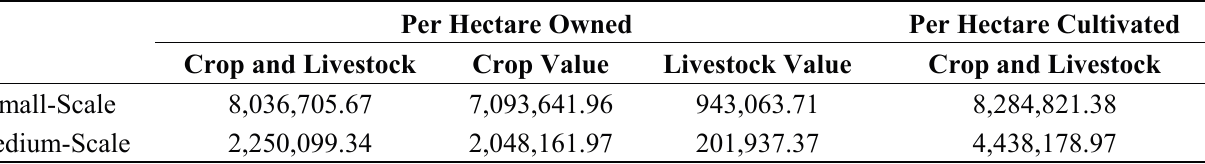
Table 6. Average gross value of agricultural production (Crop+Livestock, Crop, and Livestock) per hectare owned and hectares cultivated (2012 ZWK). Source: RALS